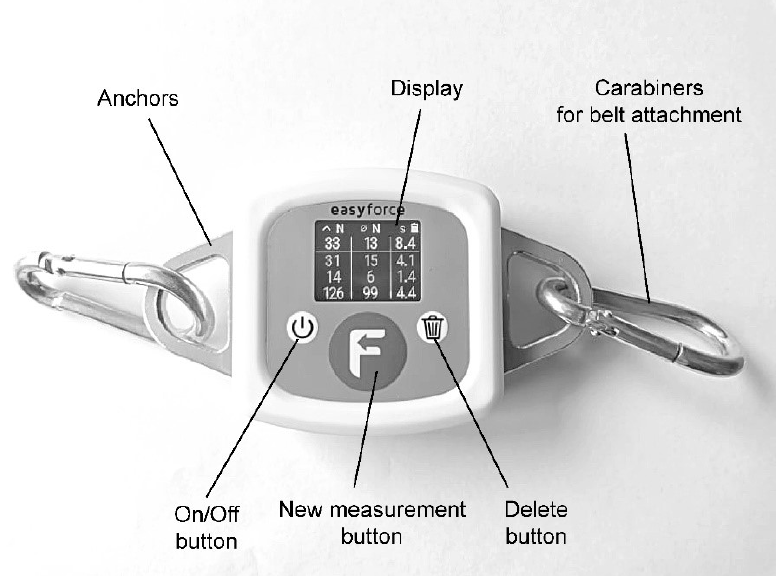
Figure 1. EasyForce dynamometer.